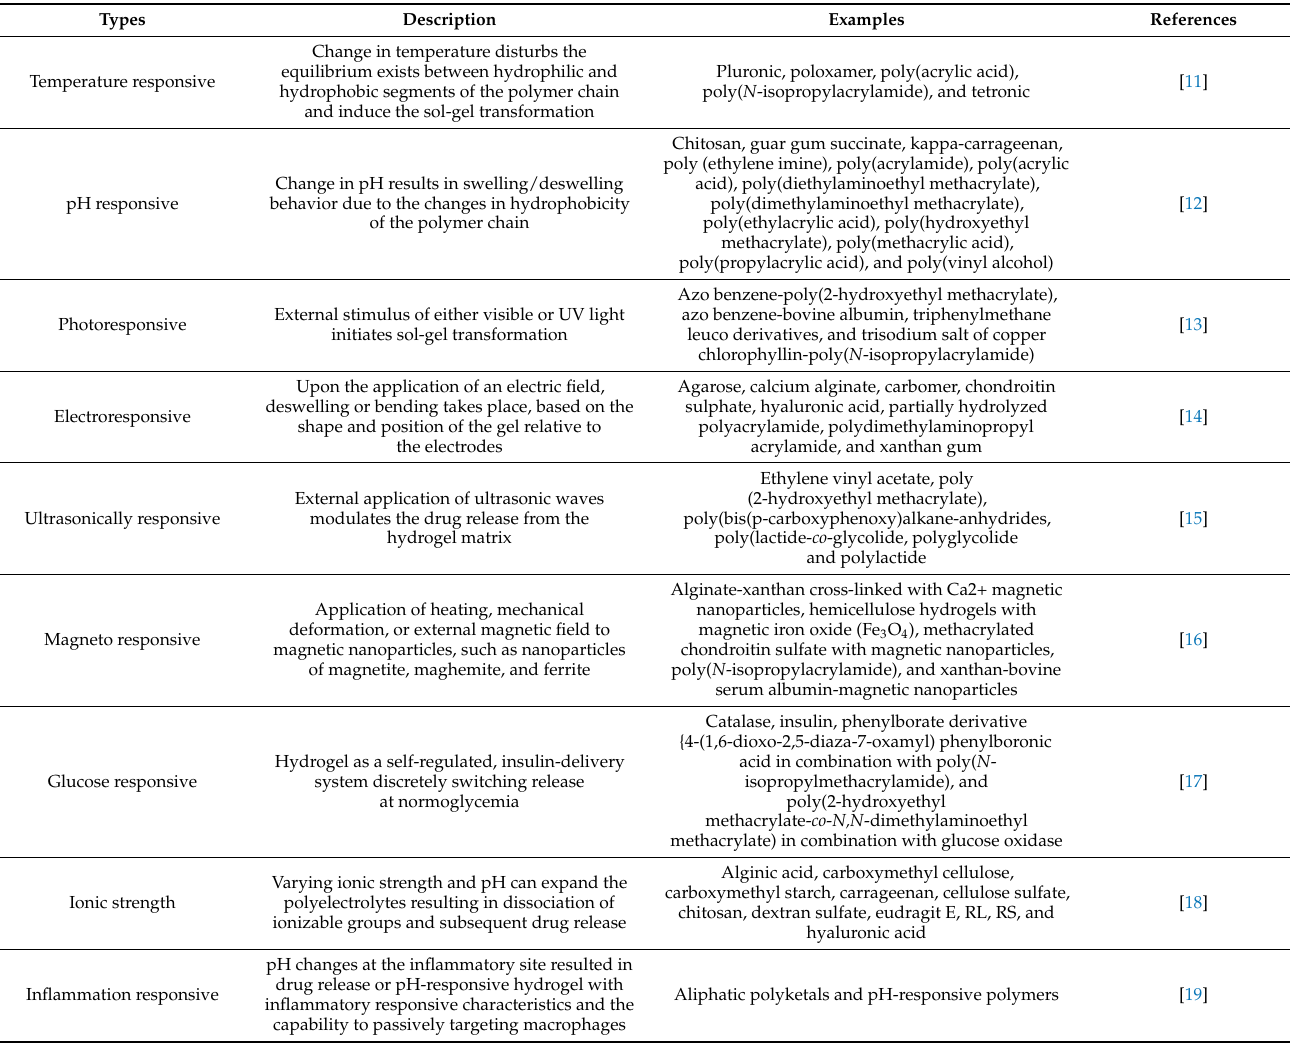
Table 2. Different kinds of stimuli responsive